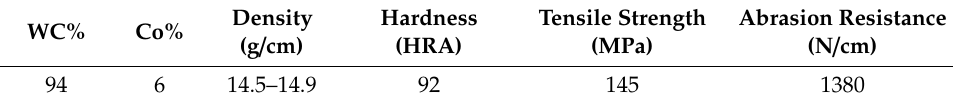
Figure 5. Self-made fixture structure diagram. Table 3. Main performance parameters of YG6 tungsten steel